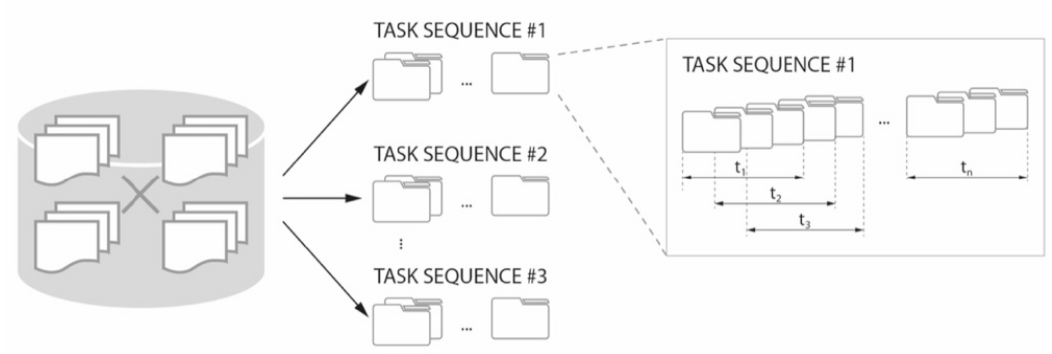
Figure 6. Schematic algorithm for task replication and dispatching in the crowdsourcing